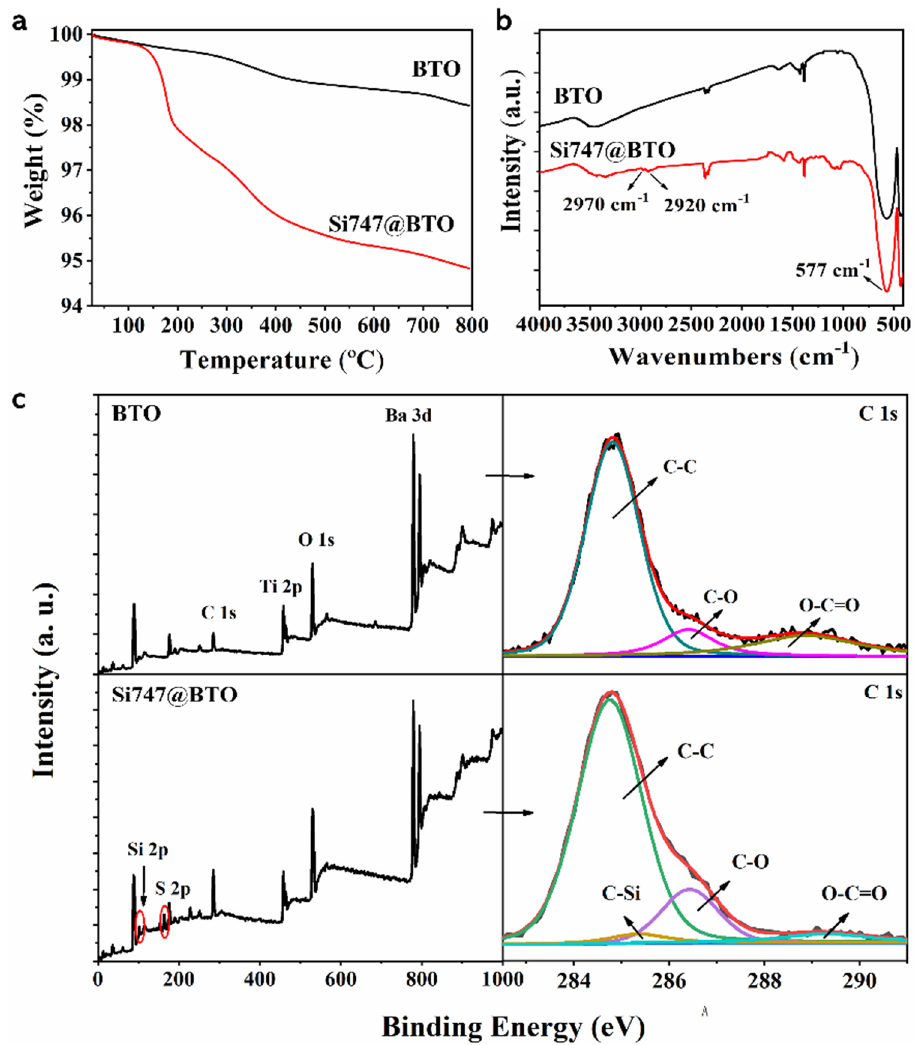
Figure 2. Structural analysis of BTO and Si747@BTO nanoparticles. ( a ) TGA curves, ( b ) FTIR spectra, and ( c ) XPS wide and C1s spectra.